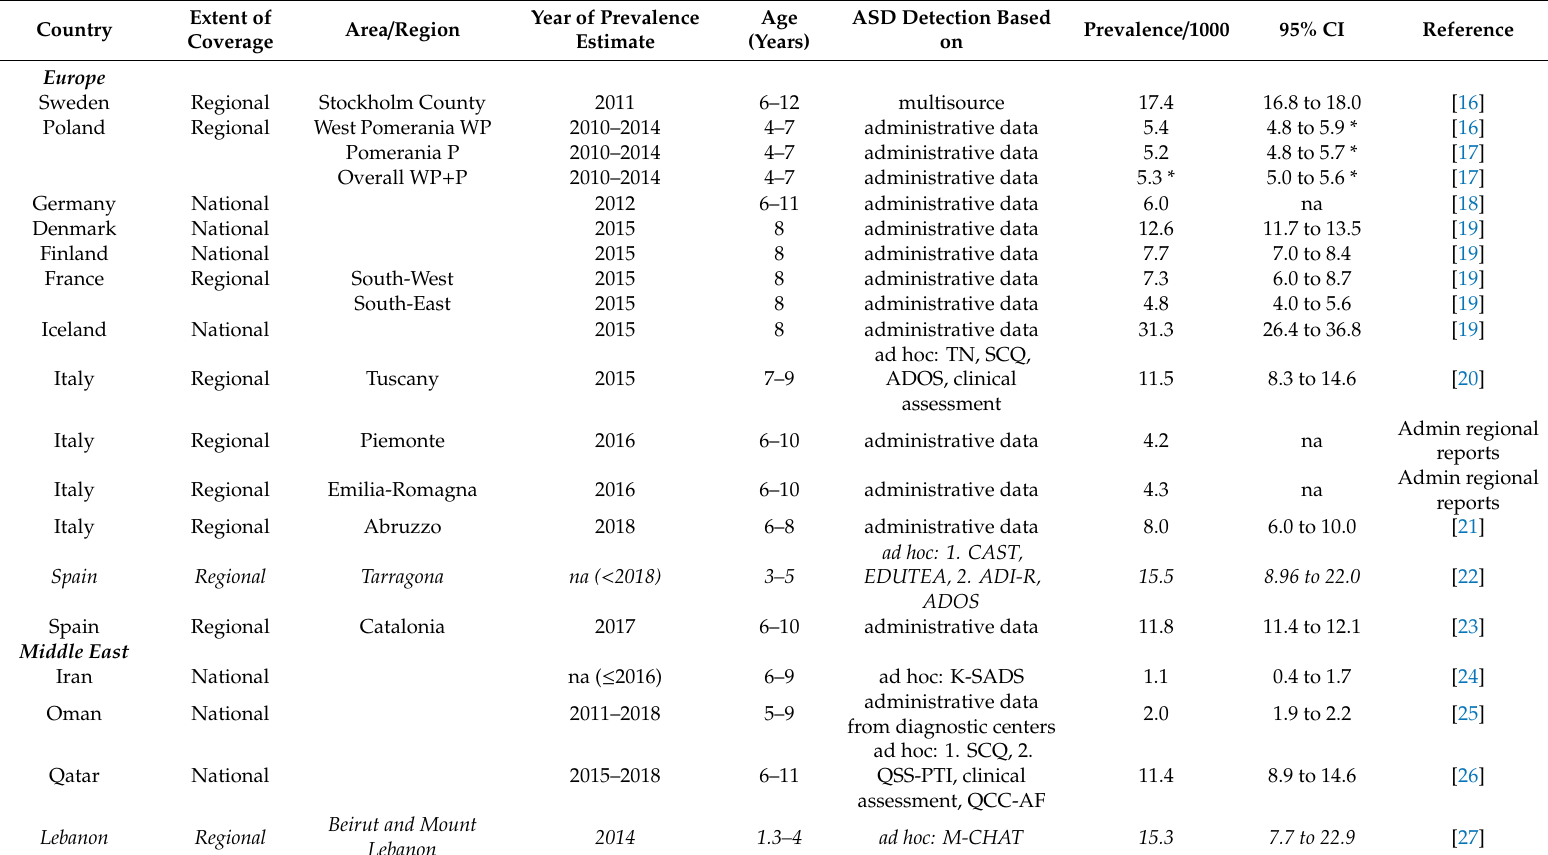
Table 2. Summary of prevalence studies published since 2014 in Europe and